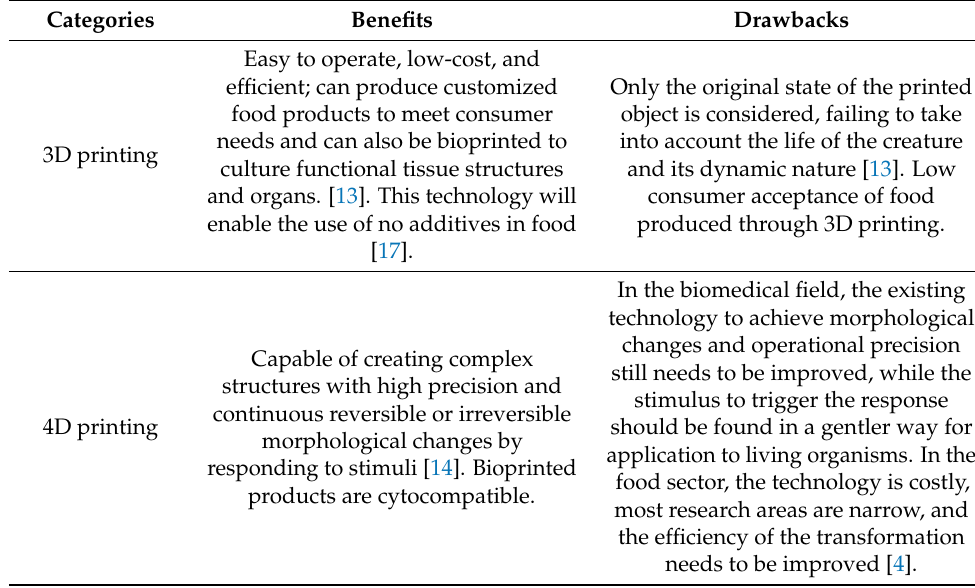
Table 2. Benefits and drawbacks of in applied 3D/4D